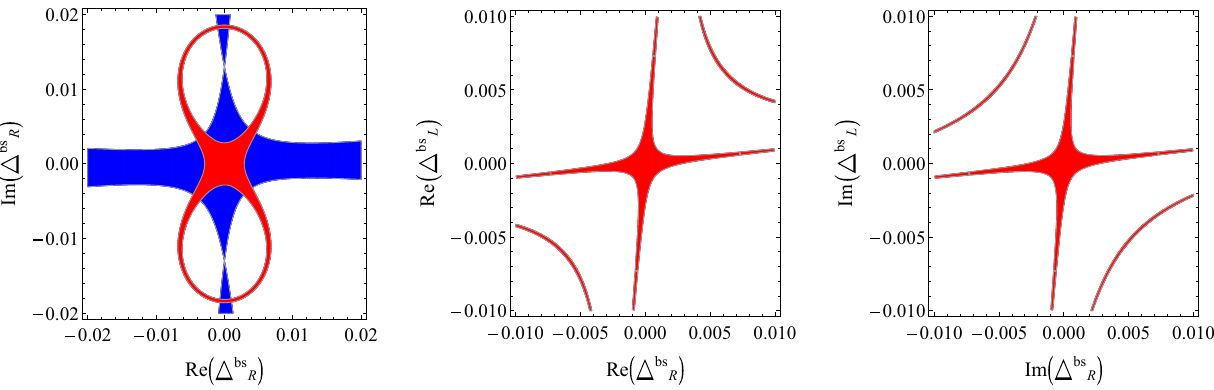
) –Im ((cid:5) bs ) plane in LRS from the R L ) = Re ((cid:5) bs ) = 0. L R